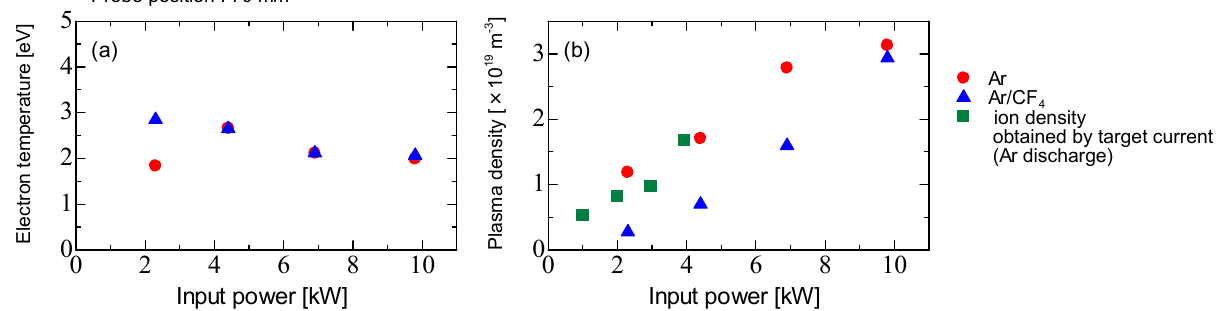
Figure 6. Plasma parameters as a function of input power. ( a ) Electron temperature and ( b ) plasma density for Ar and Ar/CF 4 discharges.